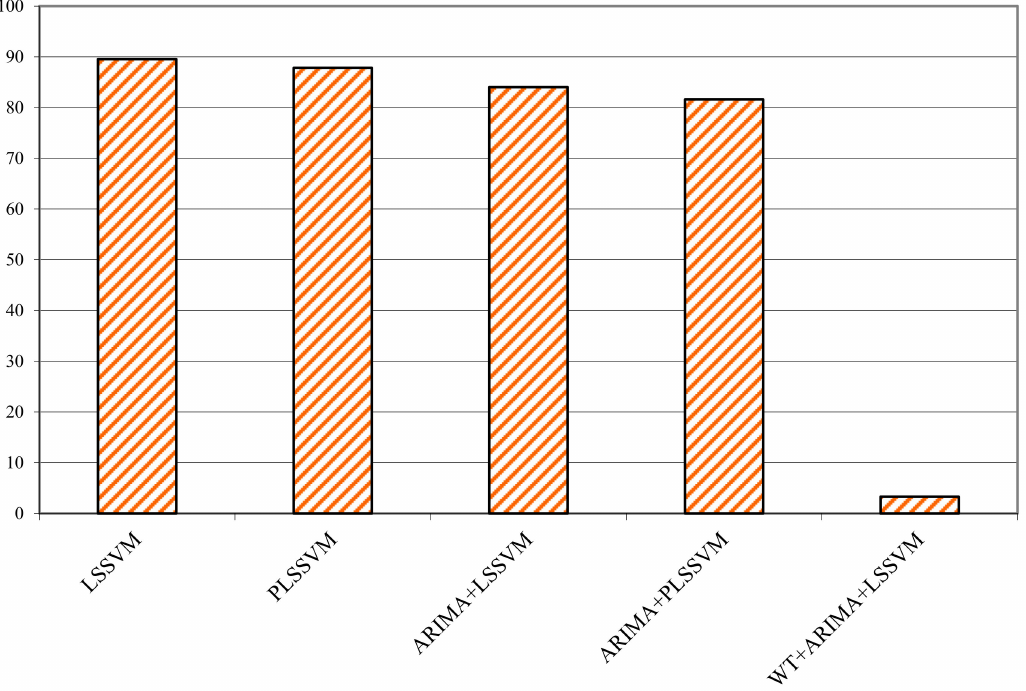
Figure 14. Comparison of the improved MAPE criterion in the proposed method and other available